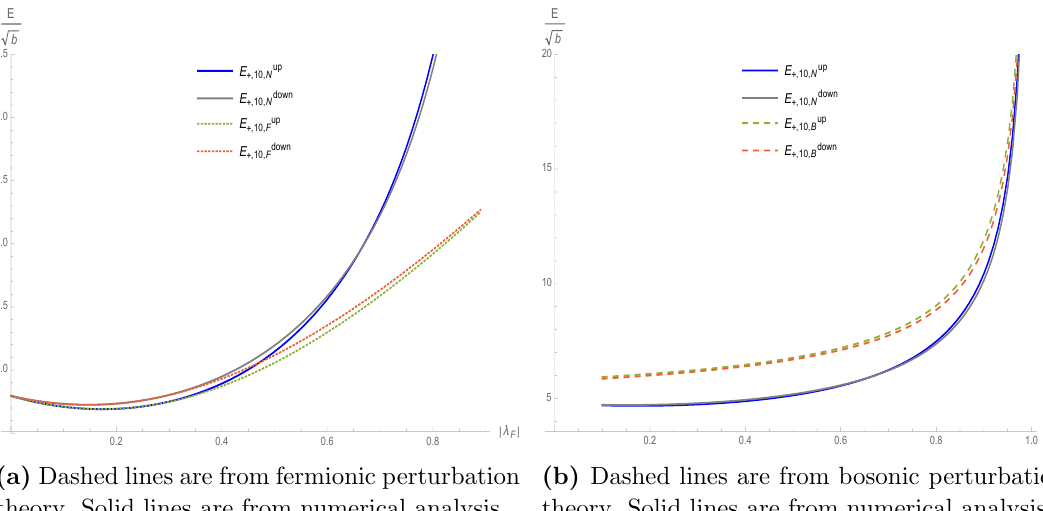
(b) Dashed lines are from bosonic perturbation theory. Solid lines are from numerical analysis. p = (cid:0) j b j B